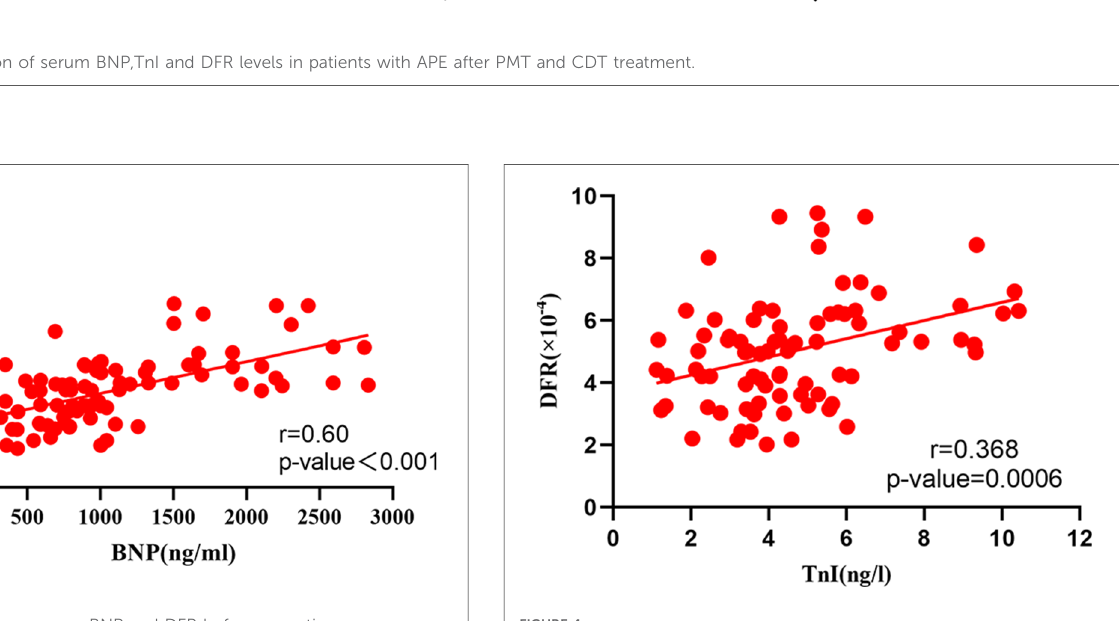
FIGURE 4 Correlation between serum TnI and DFR before operation.